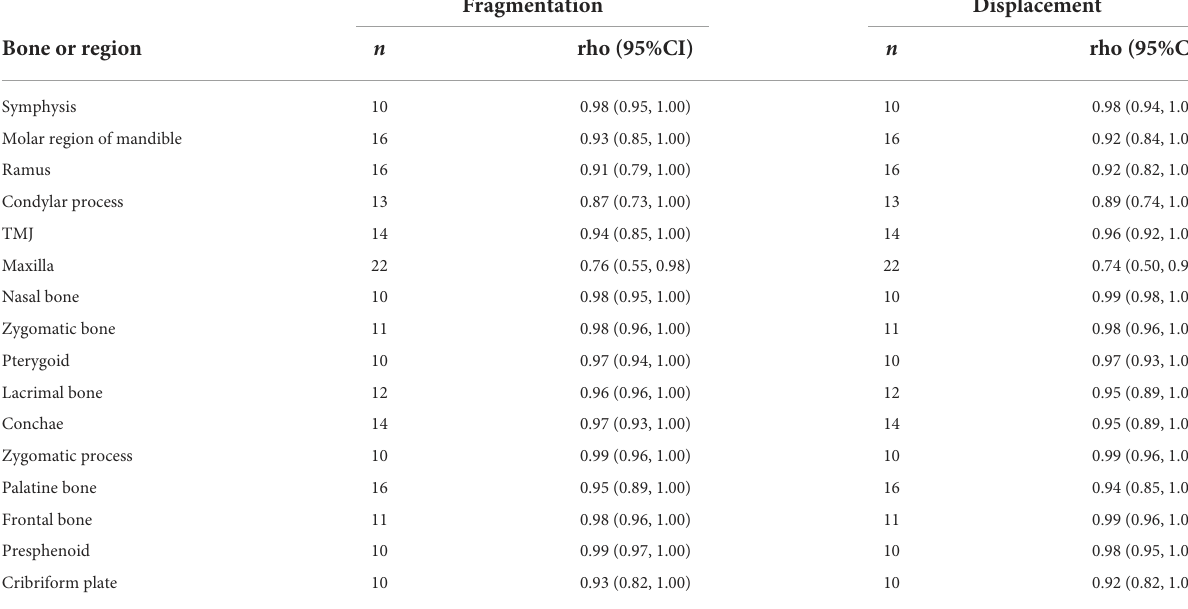
TABLE 3 Spearman correlation between severity of fragmentation and displacement in relation to fracture healing outcomes.